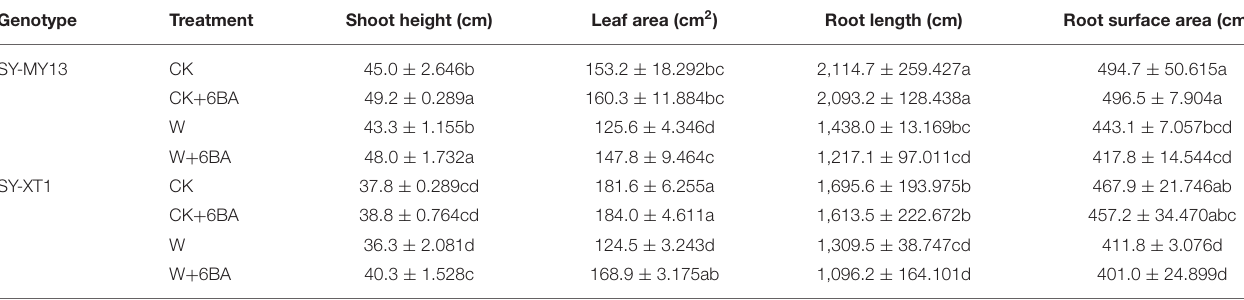
TABLE 2 | Effects of 6-BA on the growth of two waxy corn inbred lines experiencing waterlogging stress.